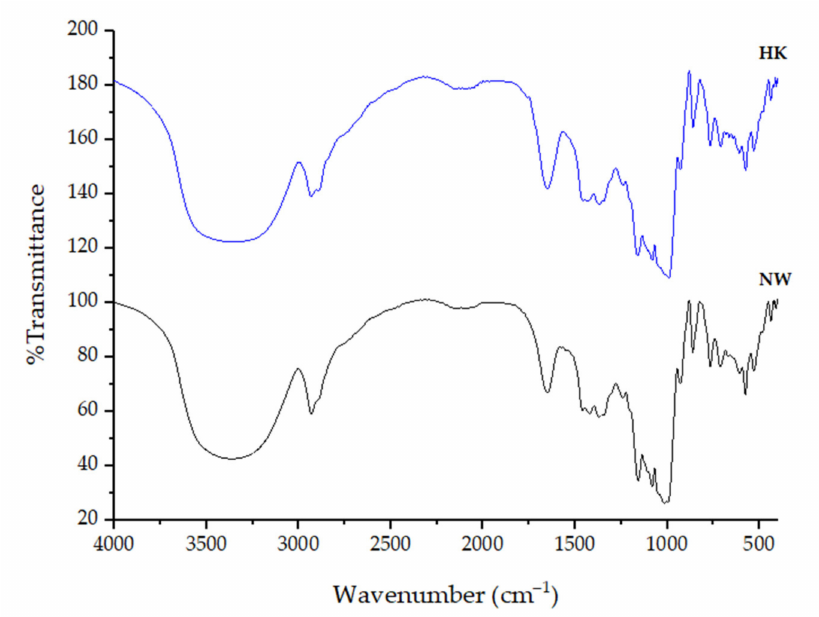
Figure 3. FT-IR of M. acuminata (AAA; HK) and M. sapientum L. (ABB; NW)